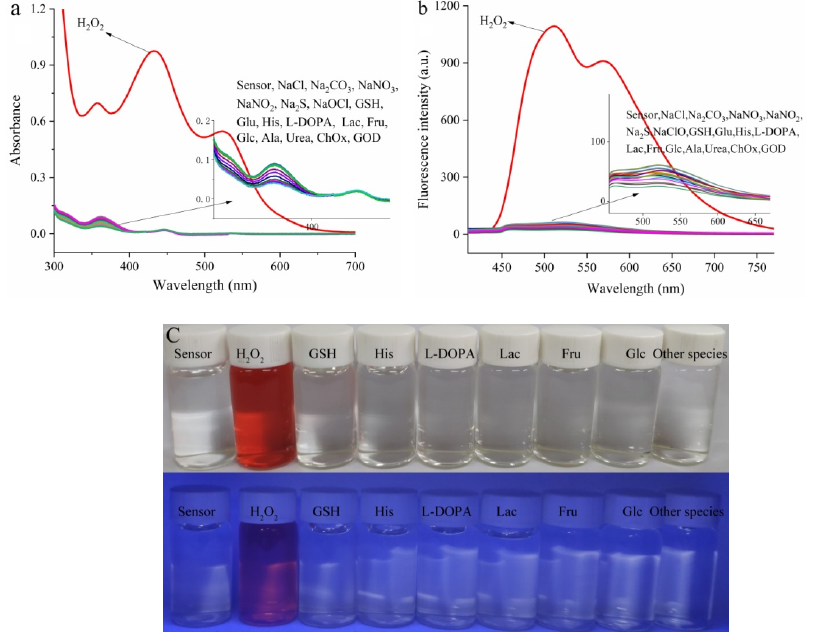
Figure 2. ( a ) UV–Vis spectra of FLA-Boe (10 − 4 mol•L − 1 ) in DMSO/H 2 O (1/1, v / v ), ( b ) fluorescence spectra of FLA-Boe in the presence of different test objects (10 − 5 mol•L − 1 ) in DMSO/H 2 O (1/1, v / v ) ( λ ex = 417 nm), ( c ) the color changes of FLA-Boe in the presence of different species in DMSO/H 2 O (1/1, v / v ) under visible light and UV light at 365 nm.